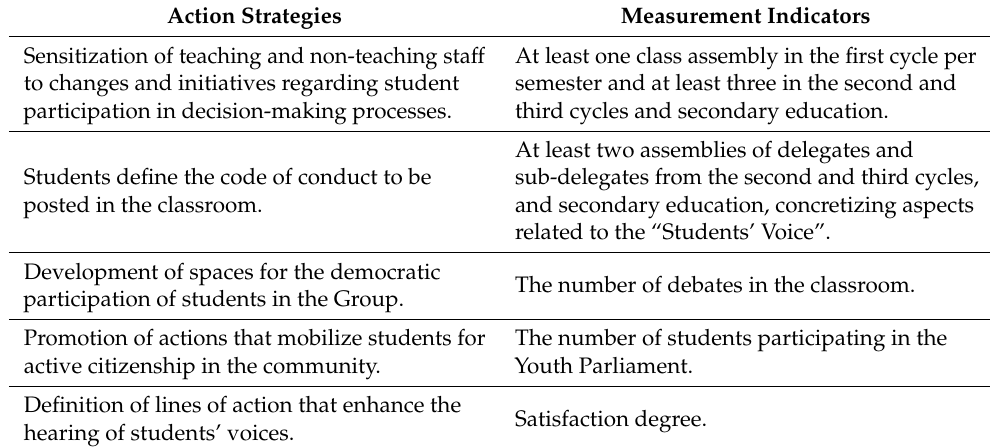
Table 2. Create opportunities for student participation in decisions about their education strategies and measurement